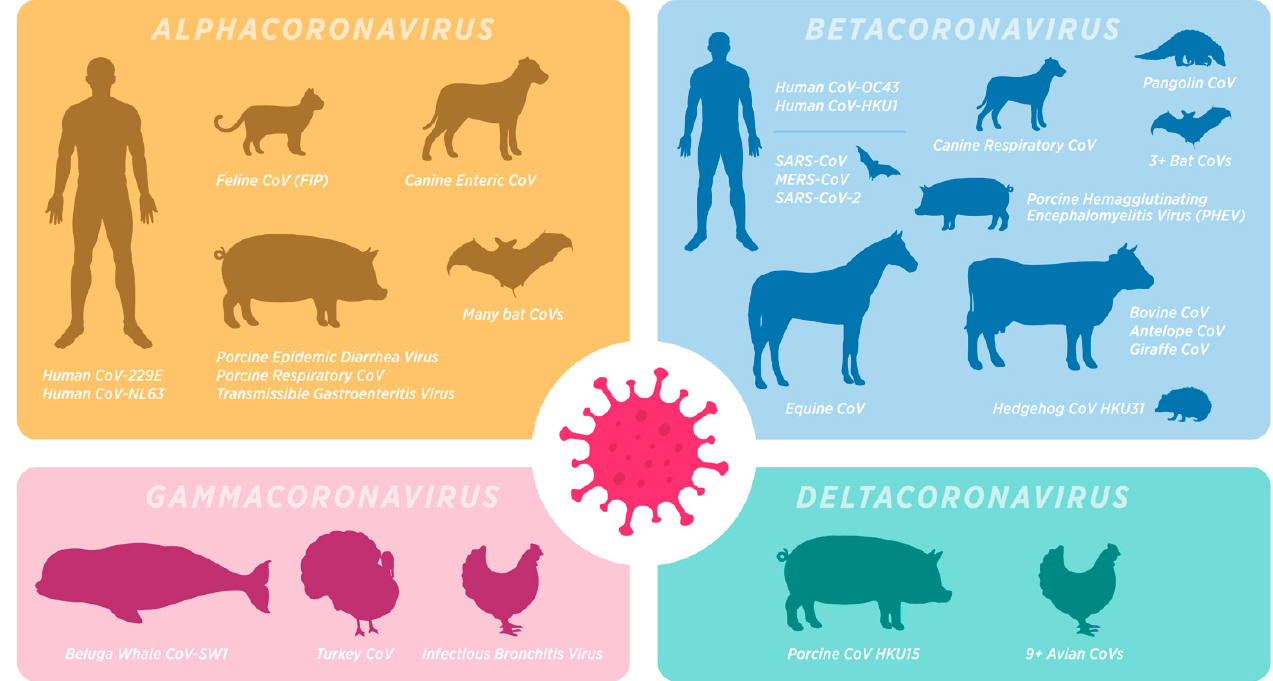
Figure 1. Mammalian coronaviruses. The Coronaviridae family frequently infects and causes disease in a wide variety of mammals. Disease presentations vary based on tissue tropism from mild, self-limiting upper respiratory infections (such as with the alphacoronaviruses CoV-229E and CoV-NL63) to more severe respiratory or systemic diseases such as the SARS-like viruses and enteric diseases of critical veterinary importance, especially those in pigs, cats, dogs, and cattle. Coronaviruses undergo frequent host-shifts between mammals, creating a need to better delineate both origins for non-human mammal coronaviruses that infect humans and mammals that have potential to act as natural reservoirs for human and veterinary diseases.